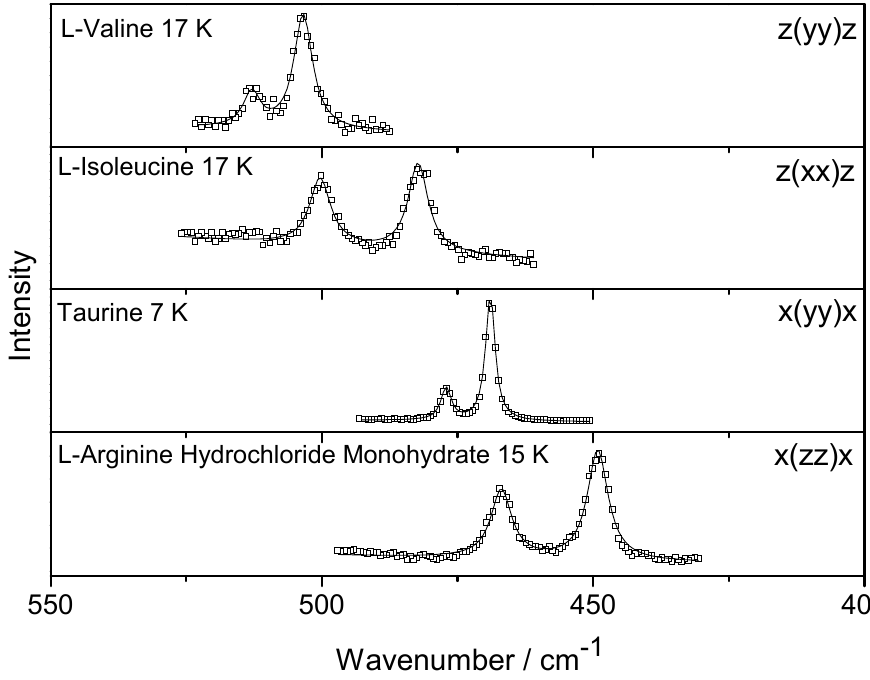
Figure 1. The Raman bands associated with the NH 3+ torsional vibration at low temperature for L-valine (VAL), L-isoleucine (ISO), taurine (TAU), and L-arginine hydrochloride monohydrate (AHM).